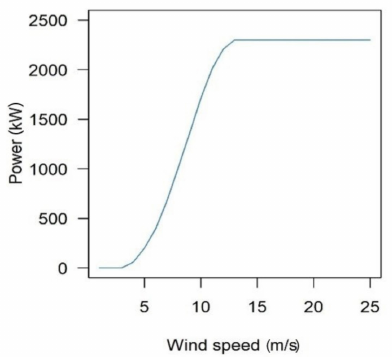
Figure 2. Wind turbine power